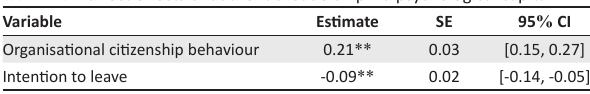
FIGURE 2: The structural model of authentic leadership, PsyCap, organisational citizenship behaviour and intention to leave. TABLE 2: Indirect effects of authentic leadership via psychological capital.